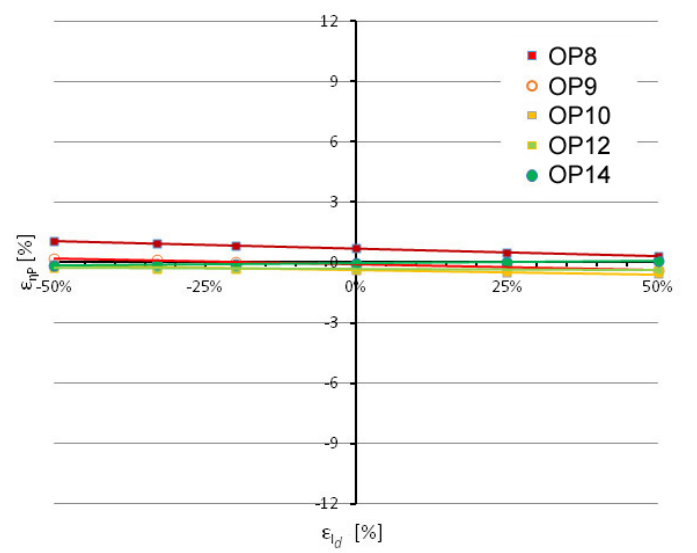
Figure 13. The algorithm sensitivity analysis regarding the determination of the pump efficiency (cid:101) η for deviation in the length of the discharge line (cid:101) l flange for the five operating points: OP8, OP9, OP10, OP12 and